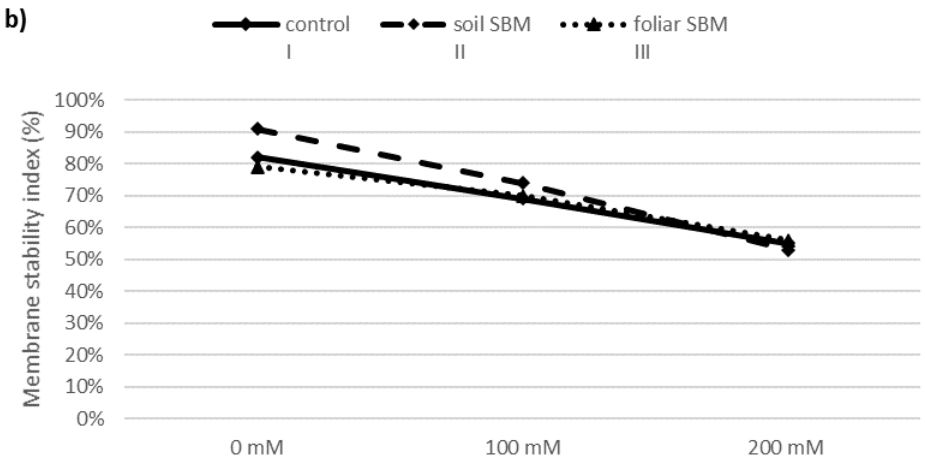
Figure 2. Malondialdehyde (MDA) ( a ) and membrane stability index (MSI) ( b ) in the shoots of the Thymus serpyllum plants after five weeks of salt stress and sugar beet molasses treatments (soil SBM—sugar beet molasses applied to the soil; foliar SBM—shoot application of sugar beet molasses). Values shown are means ± SD (n = 7). For each variant of the experiment, lowercase letters indicate significant differences between NaCl level and different capital letters indicate significant differences between each variant experiment for the same NaCl level, according to Tukey’s test ( α = 0.05).